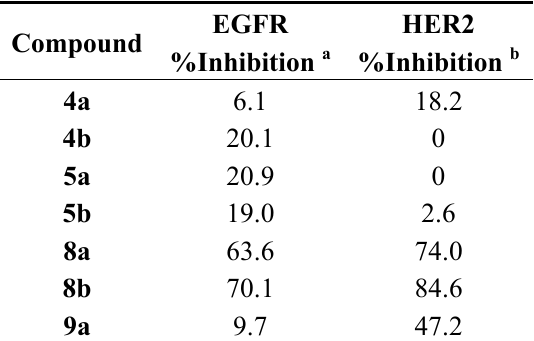
Table 2. In vitro RTK